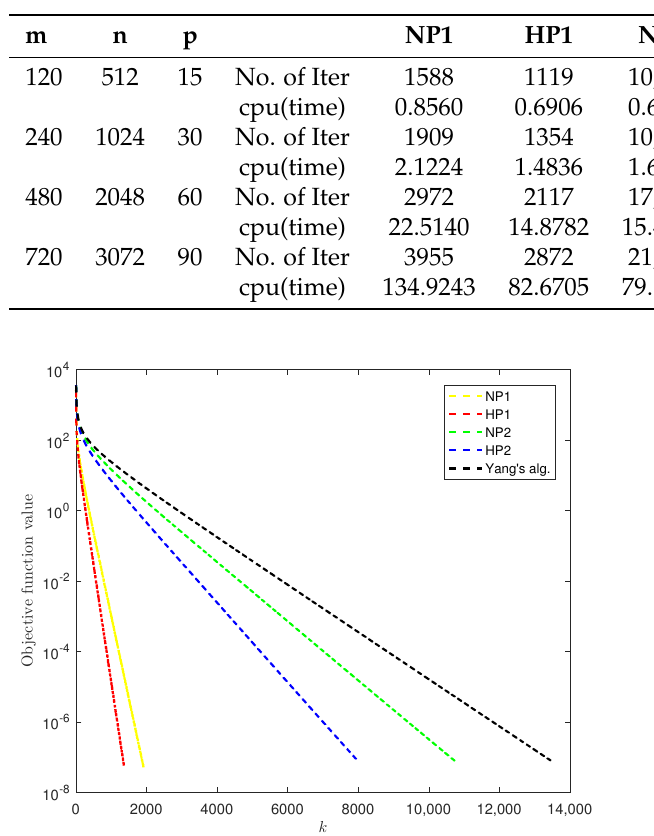
Figure 1. The objective function value versus the iteration number.